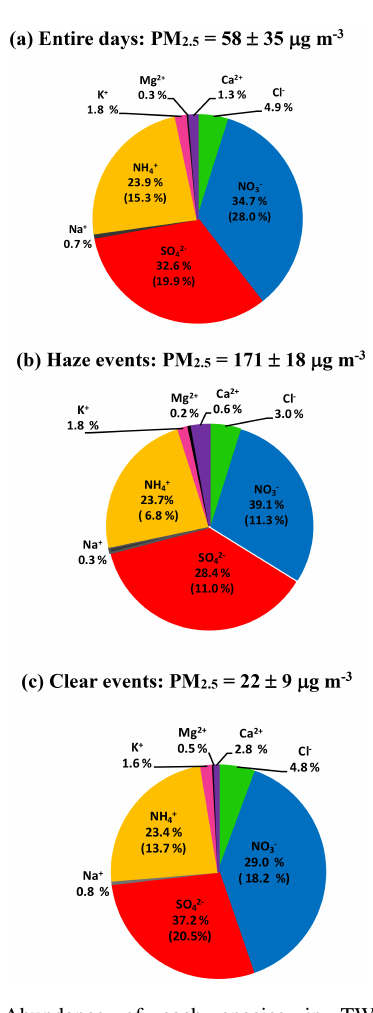
Figure 2. Abundance of each species in TWSIIs during the (a) entire, (b) haze (PM 2 . 5 ≥ 150µgm − 3 ) and (c) clear (PM 2 . 5 < 35µgm − 3 ) events. The numbers in the parentheses are standard